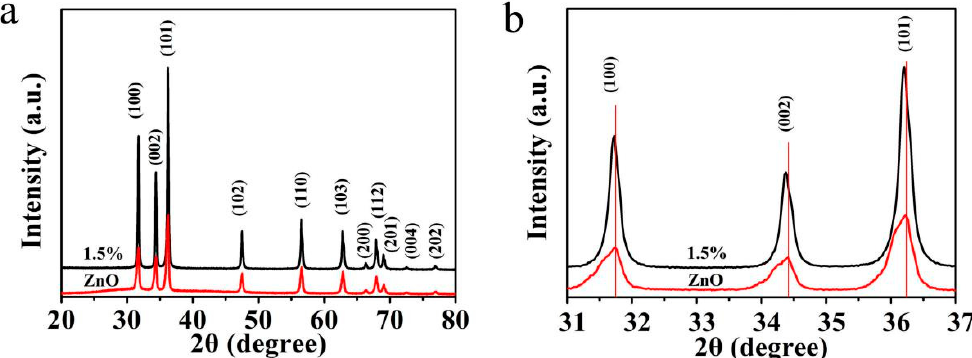
Figure 2. ( a ) XRD patterns of undoped ZnO and Mg-doped ZnO (1.5 mol%). ( b ) Magnified XRD patterns.